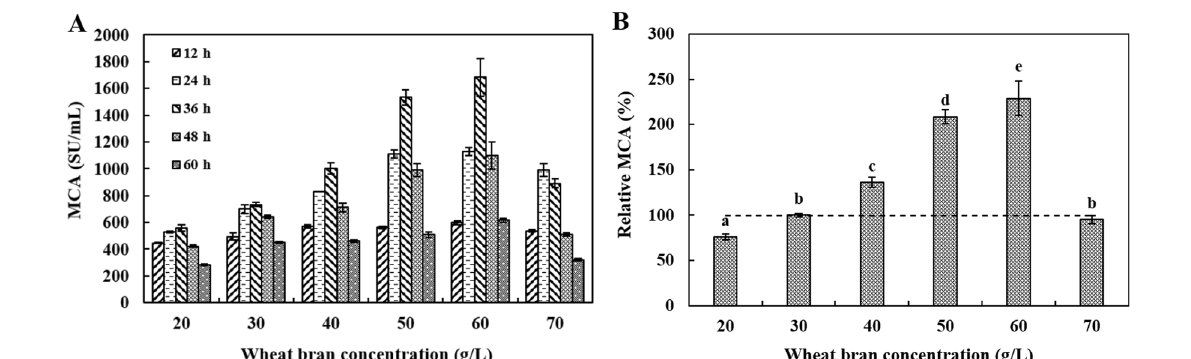
Fig. 3 The effects of different wheat bran concentration on DB219 MCE production during fermentation (12–60 h). a − e Values in the same row with different superscripts are significantly different ( P < 0.05). The data are represented as mean